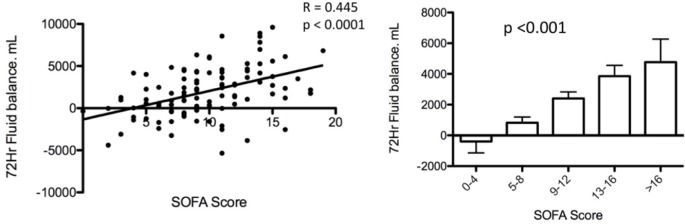
Relationship between 72-hr cumulative fluid balance (CFB) and SOFA score in patients with severe sepsis.(A) Amount of 72-hr CFB correlated well with SOFA score (r = 0.445, p < 0.0001) (data expressed as Pearson correlation); (B) The higher the SOFA score, the more 72-hr CFB was found (p<0.001 by ANOVA) (data expressed as mean ± SEM).